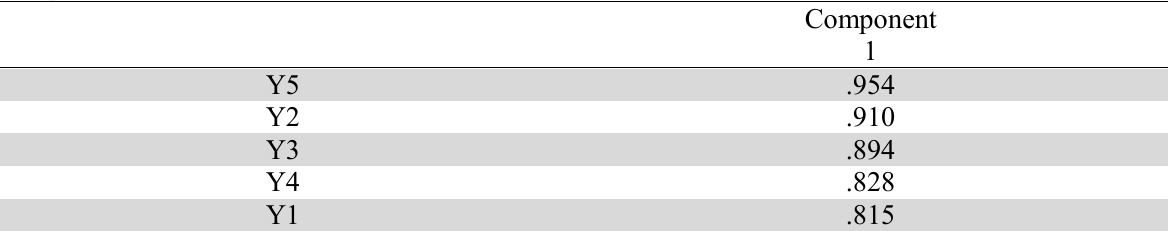
Component Matrix a